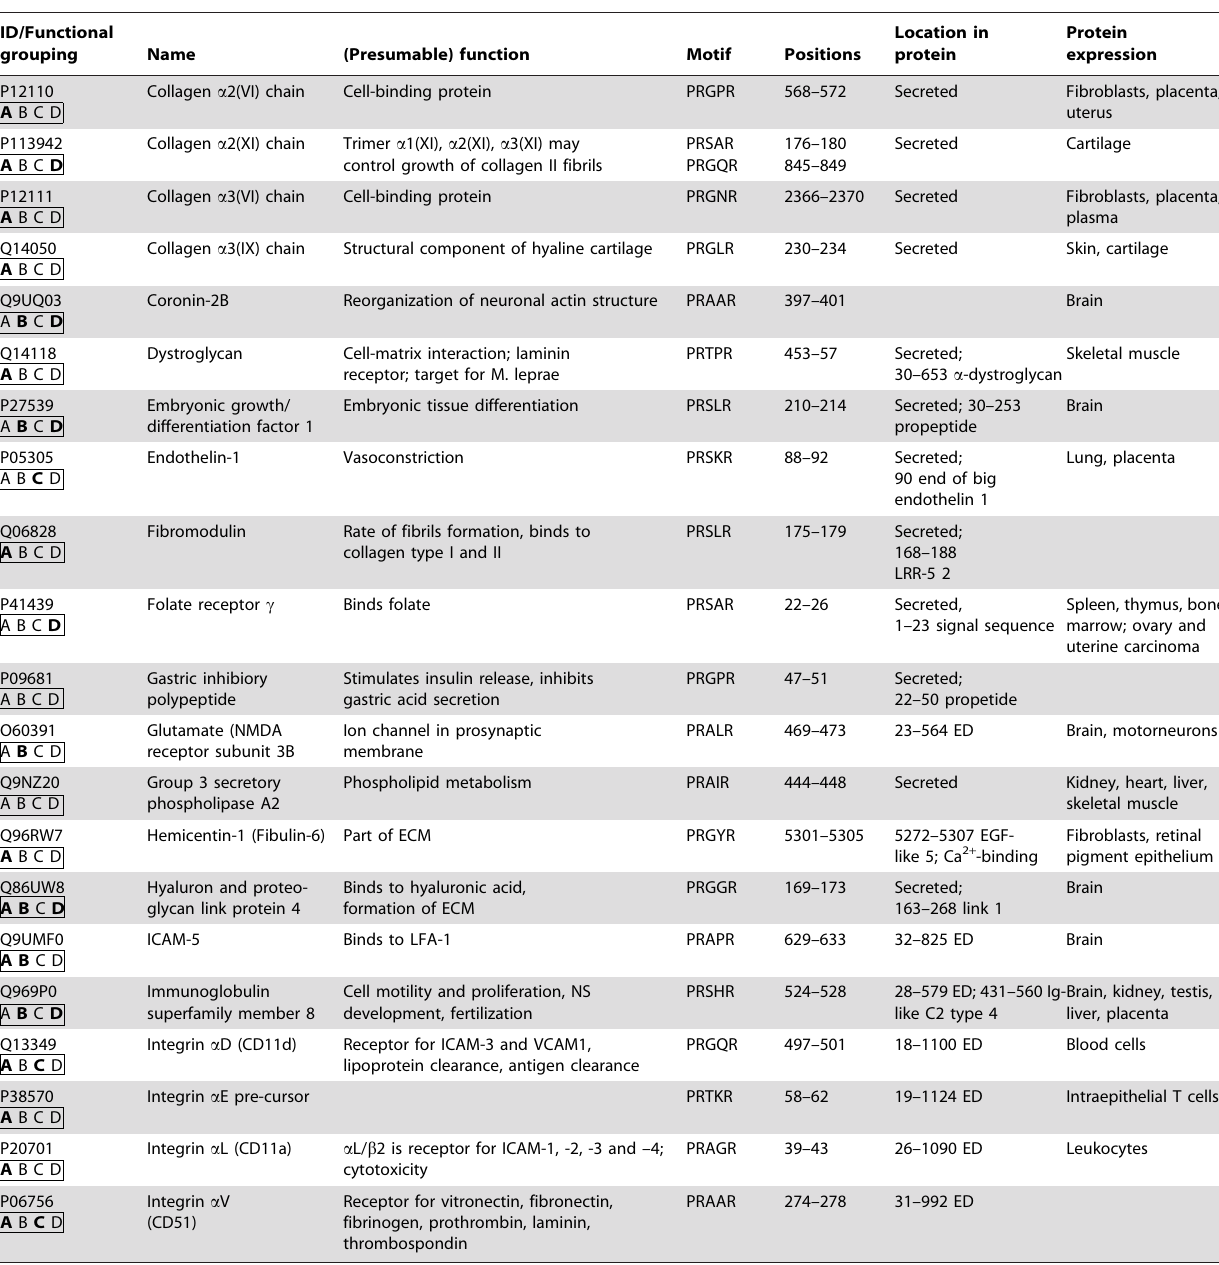
Table 4. Potential novel thrombin